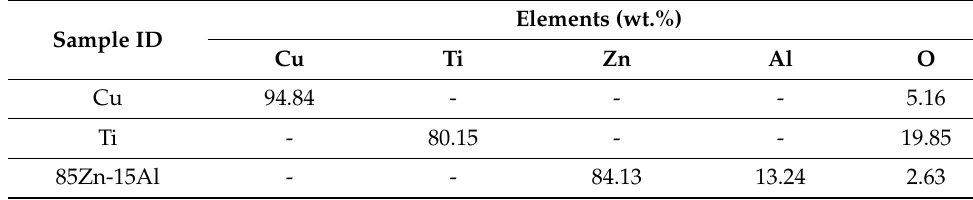
Figure 3. Cross-section SEM of ( a ) Cu, ( b ) Ti, and ( c ) 85Zn-15Al coatings at 500×. Table 1. EDS analysis of the